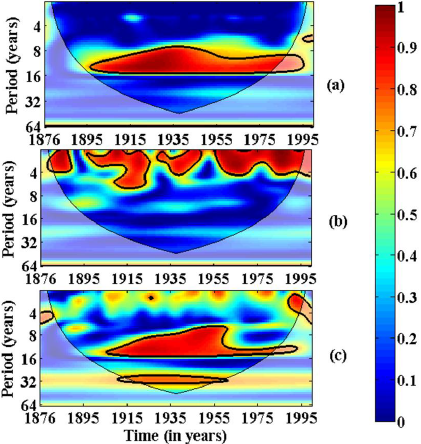
Figure 9. Squared wavelet coherence plotted for the SSA recon- structed time series between (a) WH-SSN, (b) WH-SOI, and (c) the WH-aa index, with the cone of influence (lighter shaded smooth curve) and black lines indicating significant power on the 95% level compared to the red noise based on the AR(1) coefficient.